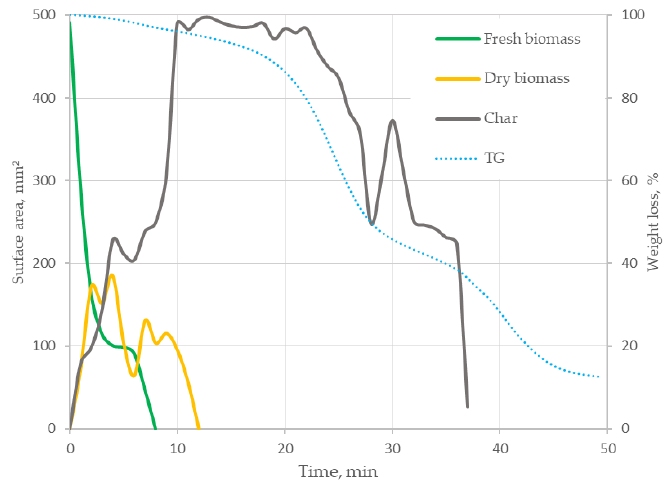
Figure 8. Change in the surface area of fresh biomass, dry biomass and char — sample 75K25J.